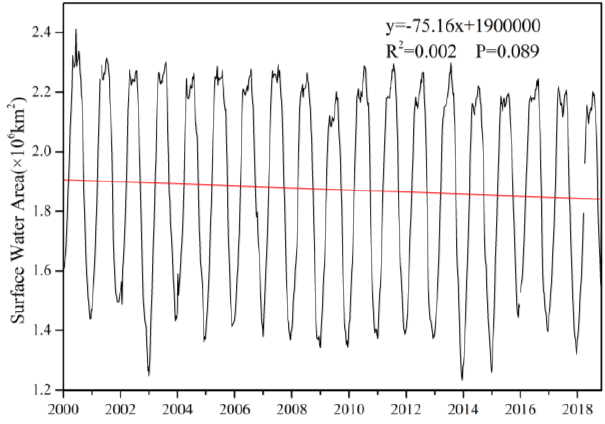
Figure 7. Changes in global water area from the year 2000 to 2018.